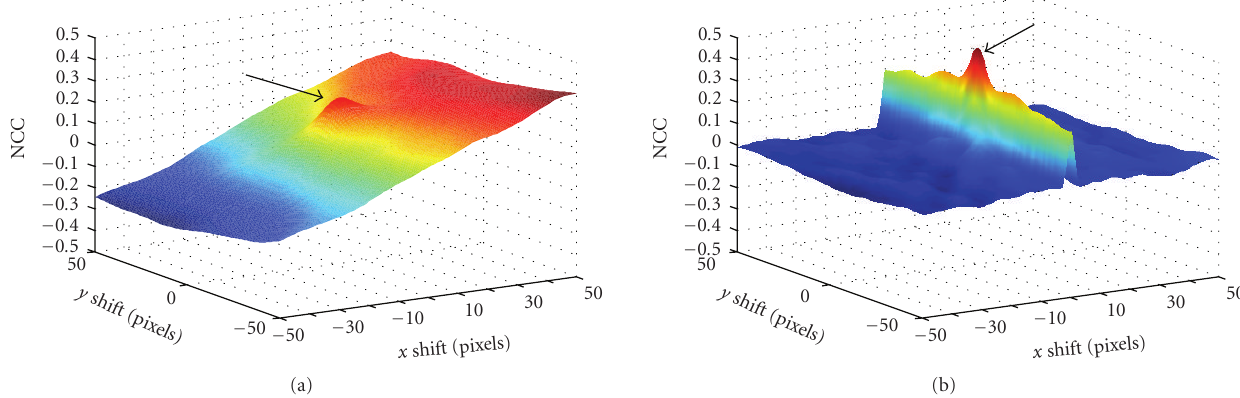
Figure 4: (a) One example of the metric (NCC) surface for original images and (b) corresponding gradient images. The IR and AF images were used and the position of the global maximum is expected position (0,0) pixels, depicted by arrows. Maximum value of the peak on the left image does not correspond to global maximum in contrast to right